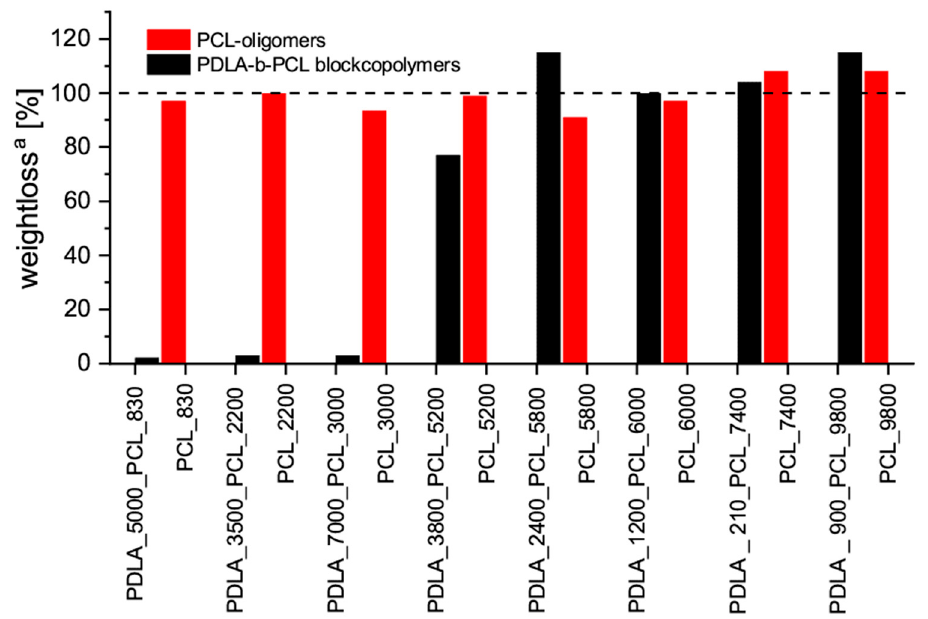
Figure 7. Migration behavior of the blends of PLLA and PDLA-b-PCL block copolymers (black) and PCL oligomers (red) in toluene; a weightloss in % based on the additive amount of PDLA-PCL block copolymers or PCL oligomers used.